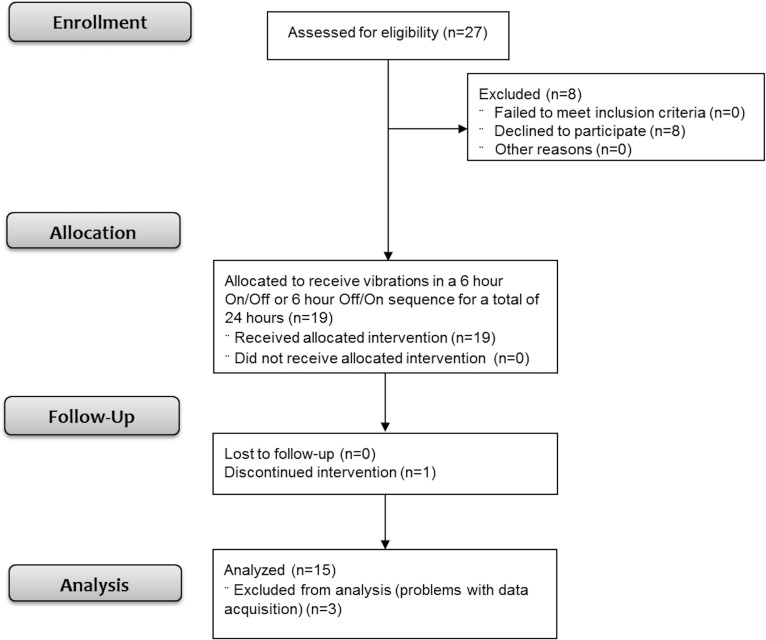
Flow of participants through each stage of the study: enrollment, assignment, allocation, intervention exposure and analysis.